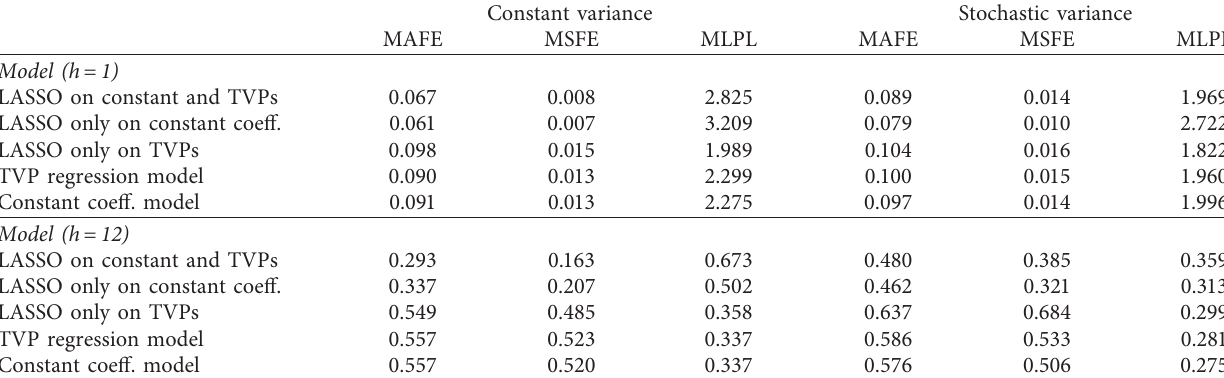
Table 7: Measures of forecast performance for log return of Brent with autoregression (AR) models.